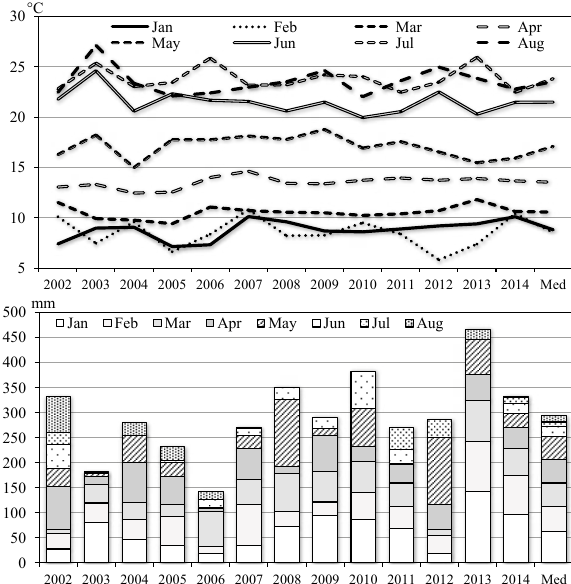
Figure 2. Monthly average temperatures (°C, lines) and monthly total rainfall (mm, bars) measured near assessed vineyards in the trial period. Med represent the average values from 2002 to 2014.